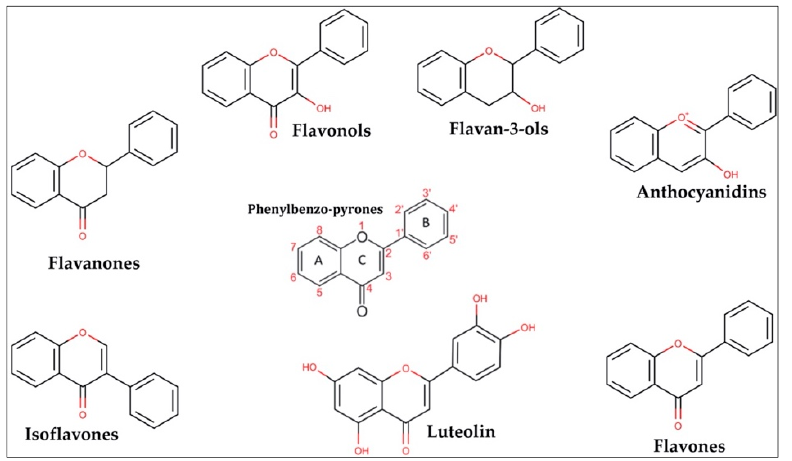
Figure 1. Chemical structures of flavonoid subclasses [9]